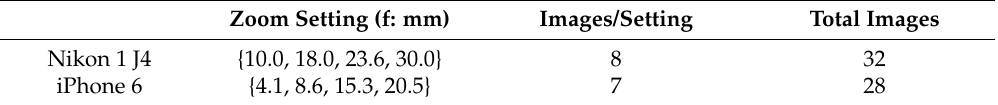
Table 2. Image information for each zoom lens calibration.